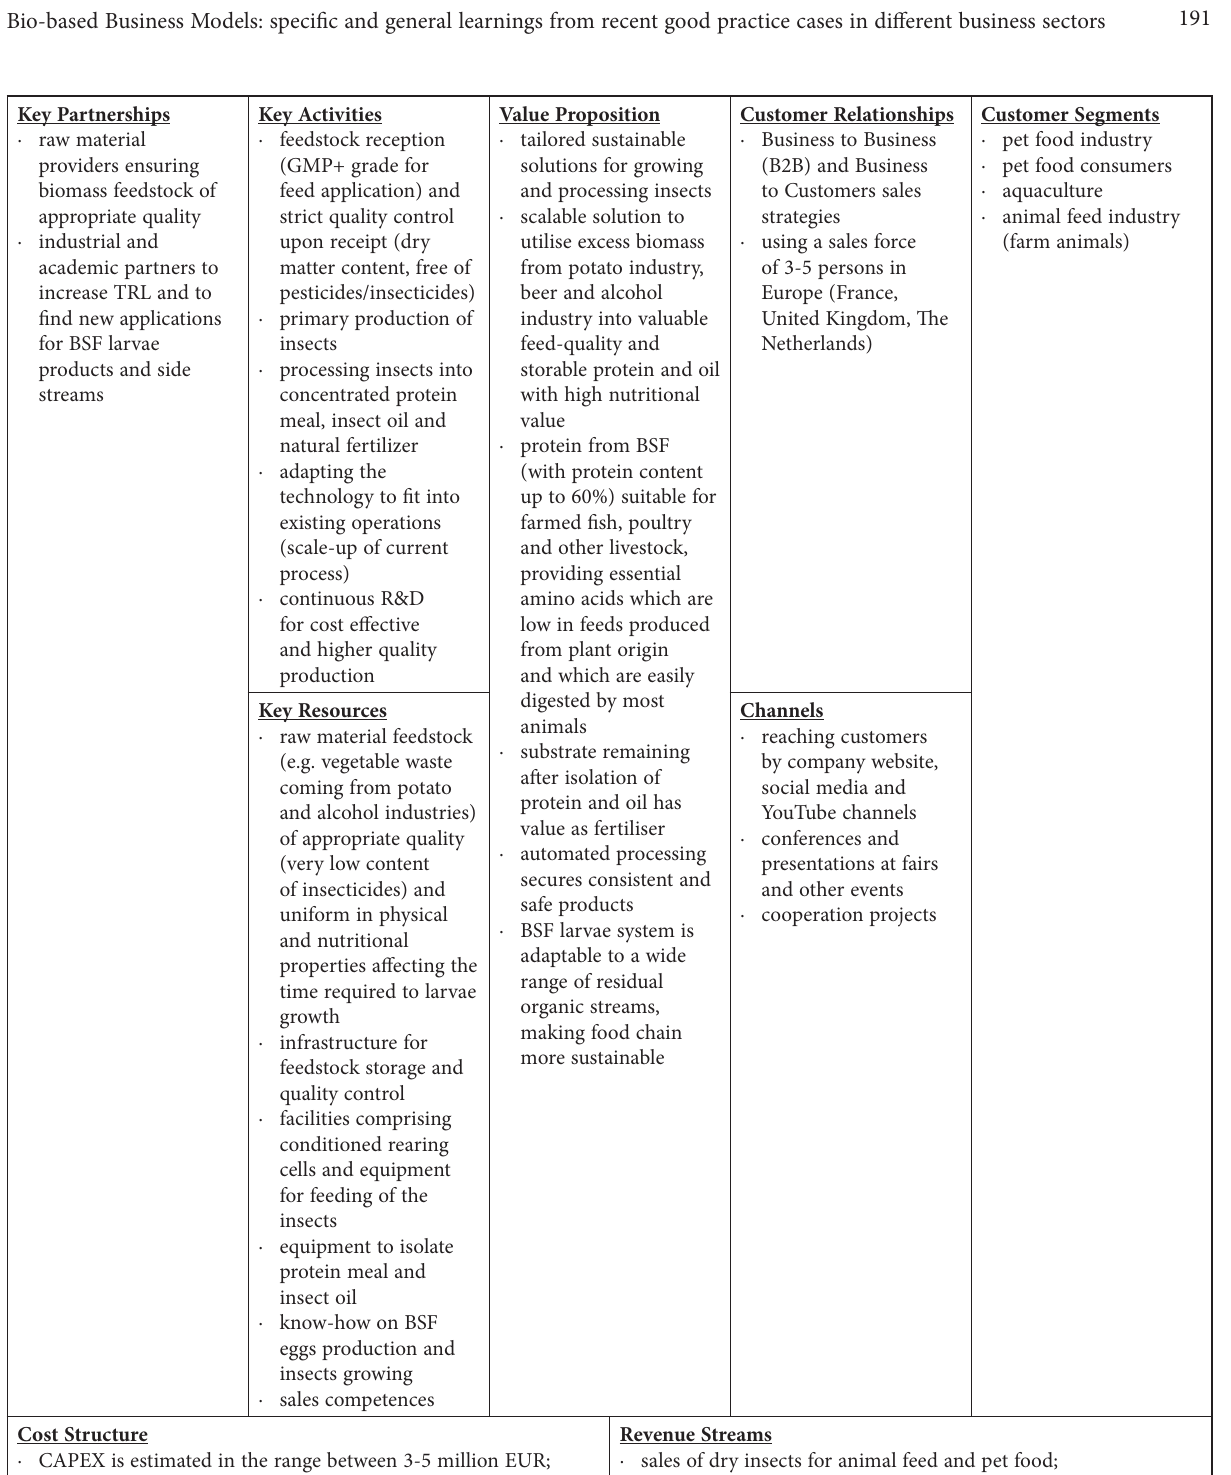
Figure 3. BMC of solution ‘S1’ (Bestico, The